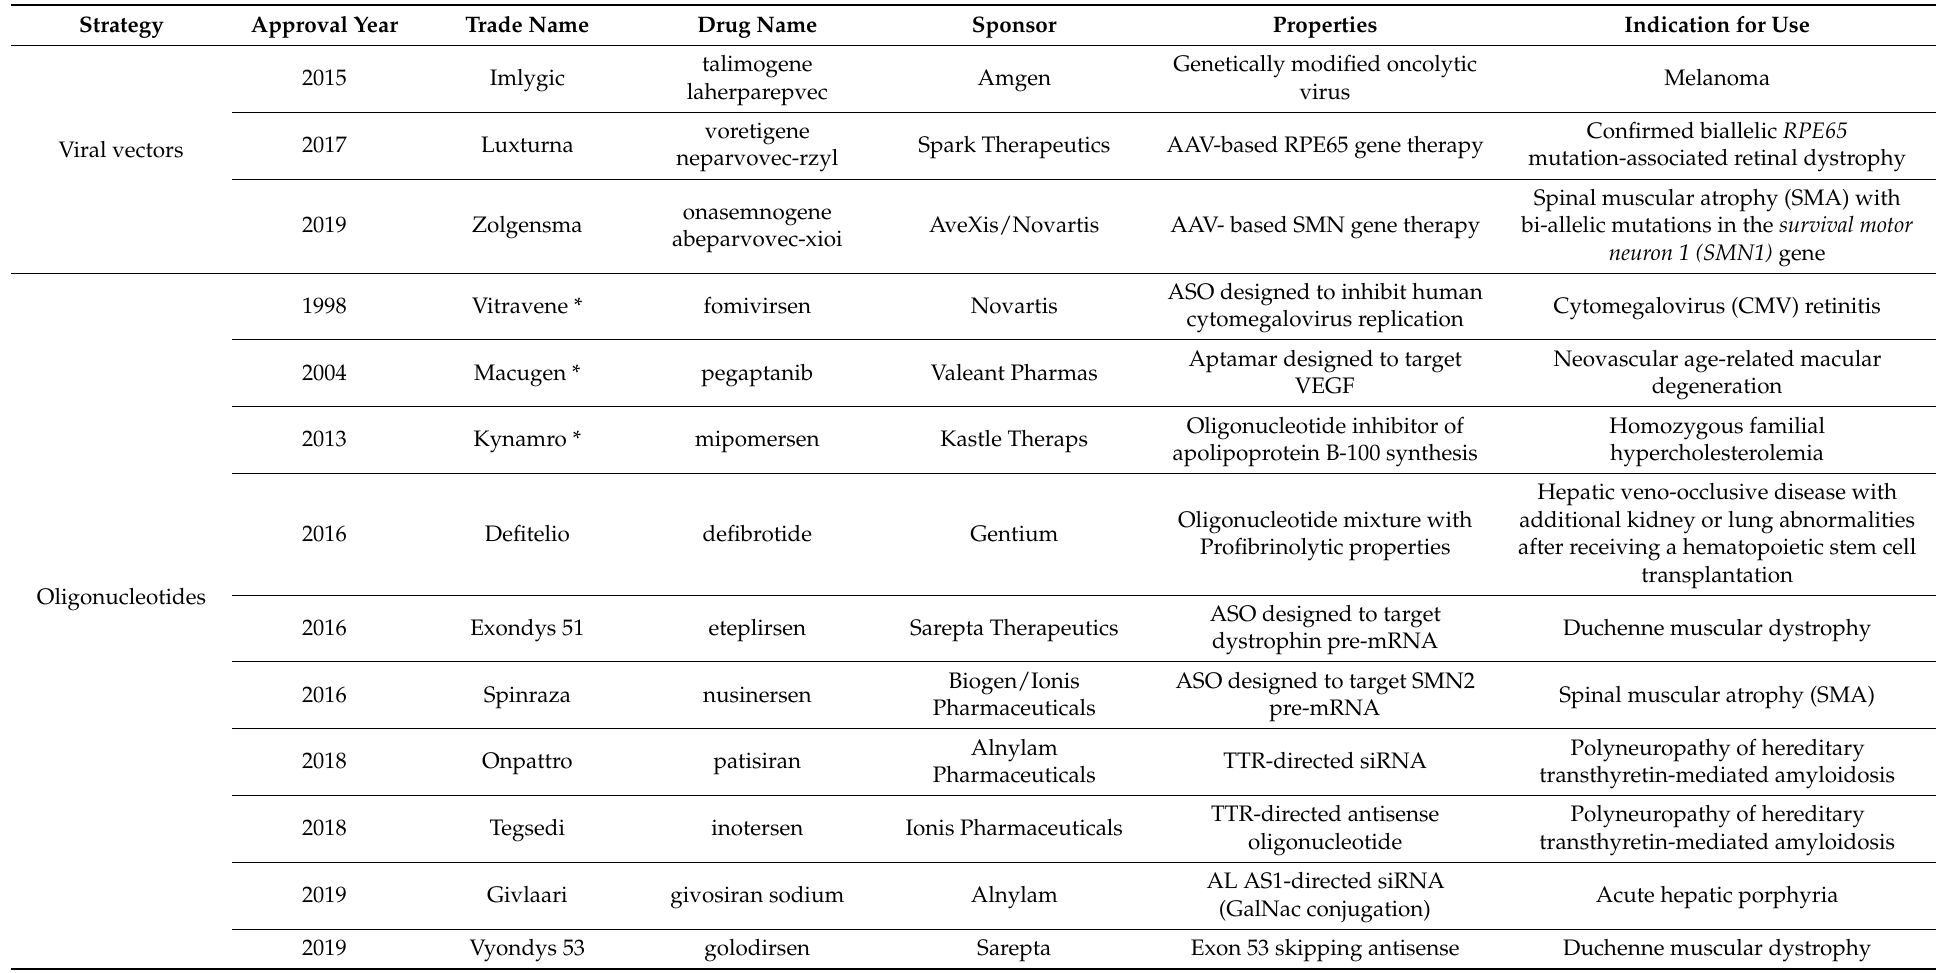
Table 4. Gene therapies approved by CBER and CDER of